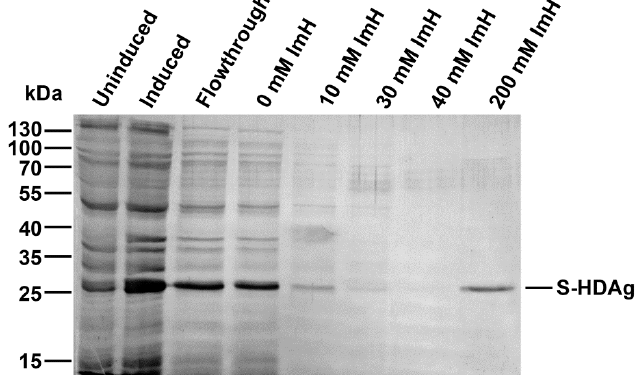
Figure 1. Expression and purification of the His-tagged small antigen of hepatitis delta virus (S-HDAg). SDS-PAGE analysis of the lysates of uninduced and induced E. coli Rosetta (DE3) cells, and of the fractions obtained during purification of the recombinant antigen on the Ni-nitrilotriacetyl agarose (Ni-NTA-agarose) column. Concentration of imidazole used for elution of His-tagged S-HDAg from the Ni-NTA-agarose column is depicted over the wells. Molecular mass markers, in kDa, are given to the left.